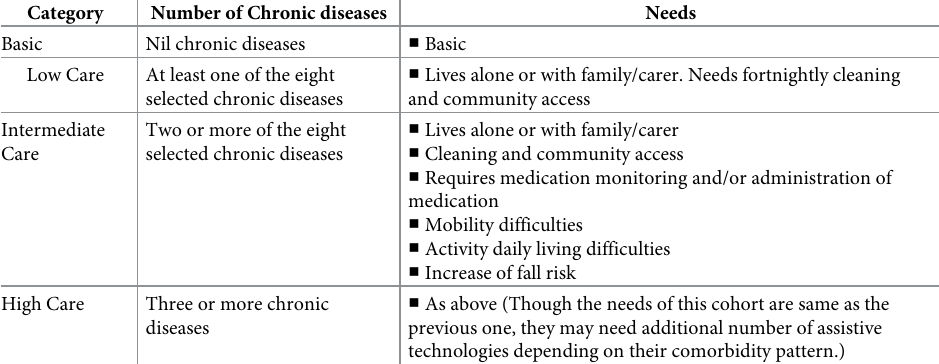
Table 5. Care needs